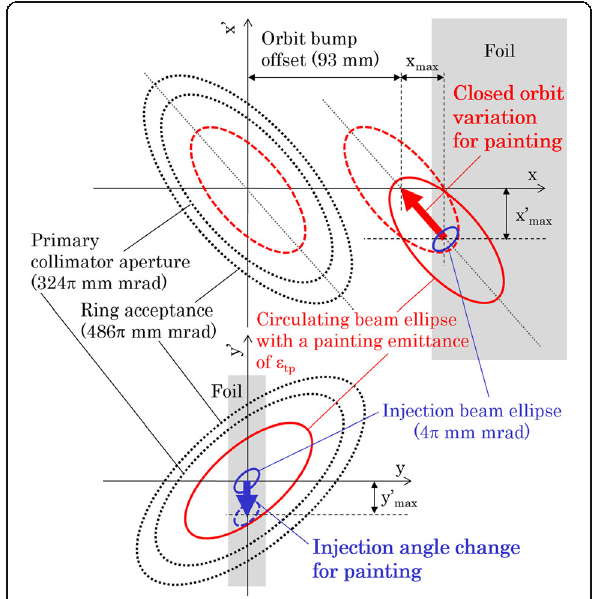
Fig. 13 Schematic diagram of the transverse phase-space painting in the J-PARC